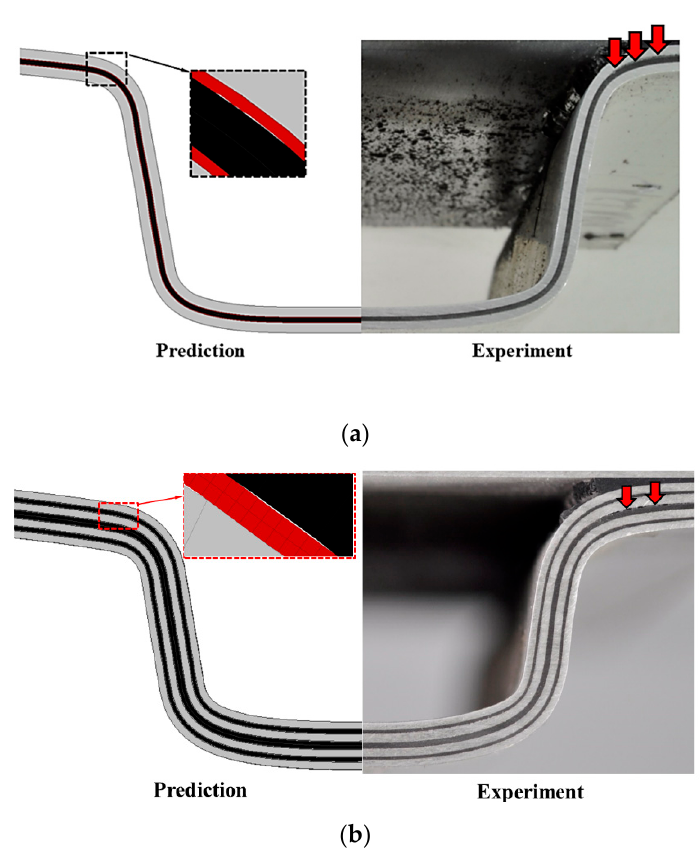
Figure 9. Delamination at the metal–polymer interface. ( a ) Final product with L1 and ( b ) semi-deformed profile with L2 at the forming load of 10 kN.